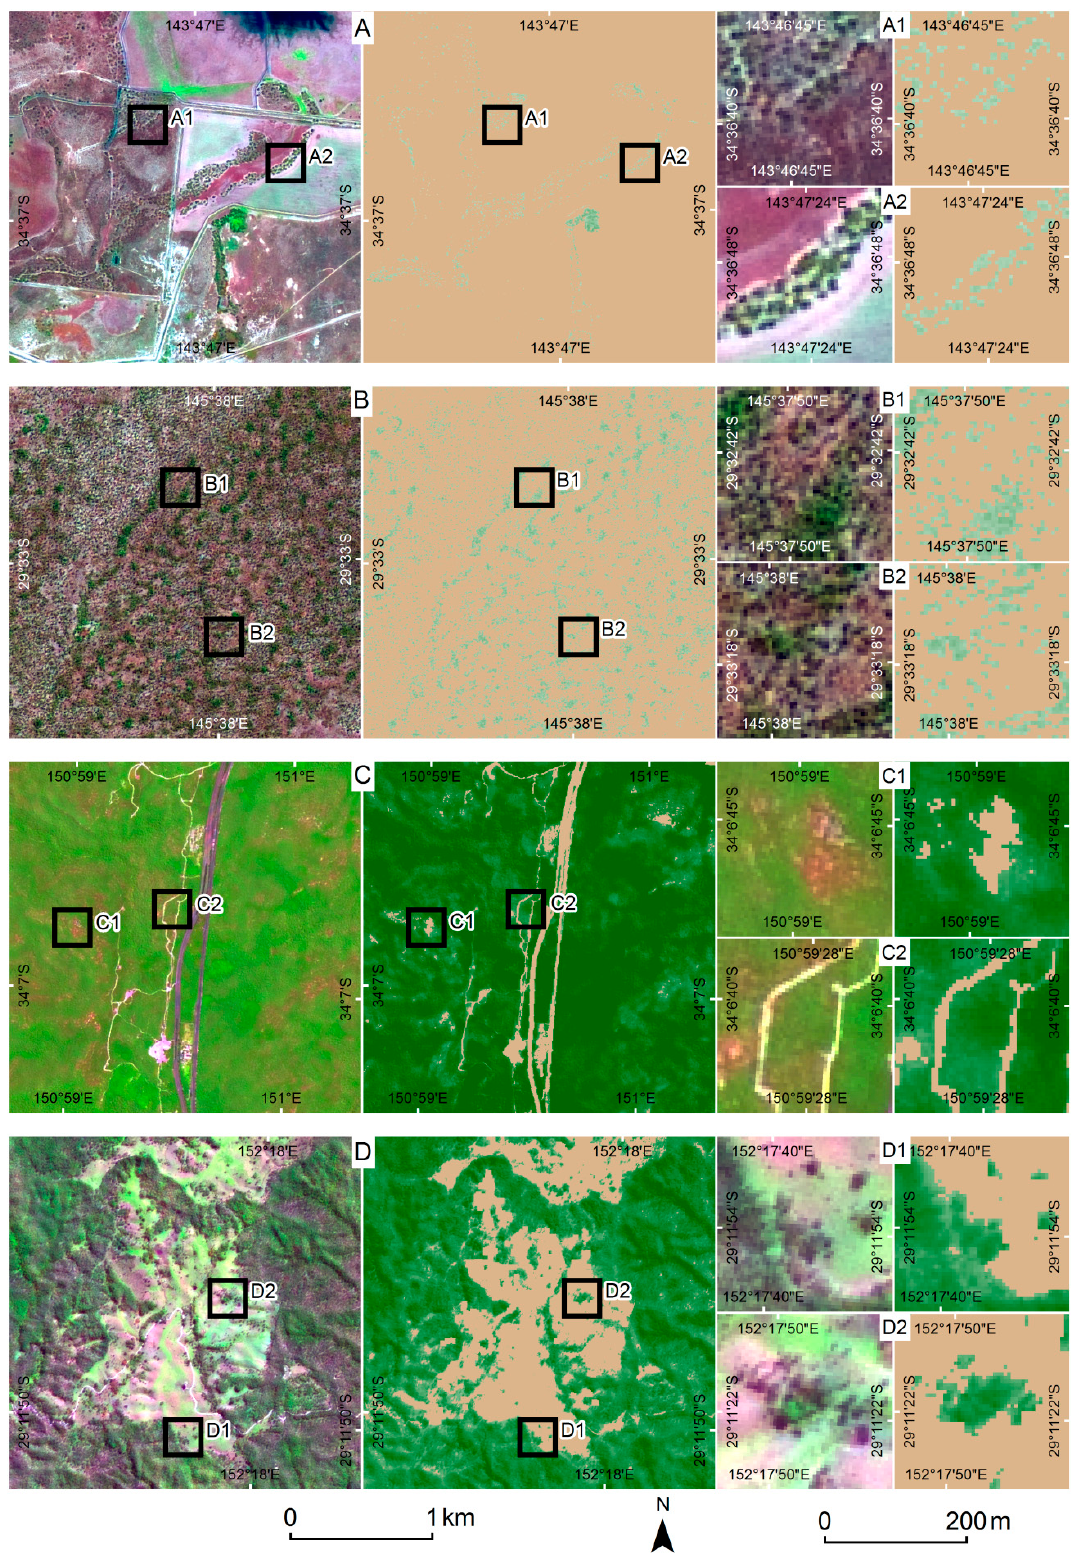
Figure 7. Examples of the final 5 m foliage projective cover (FPC) map compared to pan-sharpened false colour SPOT5 imagery. ( A ) Remnant trees in a cleared agricultural landscape; ( B ) Semi-arid open woodland; ( C ) Dry sclerophyll forest with natural and human controlled clearing; ( D ) Dry sclerophyll forest fragmented by cleared agricultural land. Example locations and FPC colour bar are shown in Figure 6.